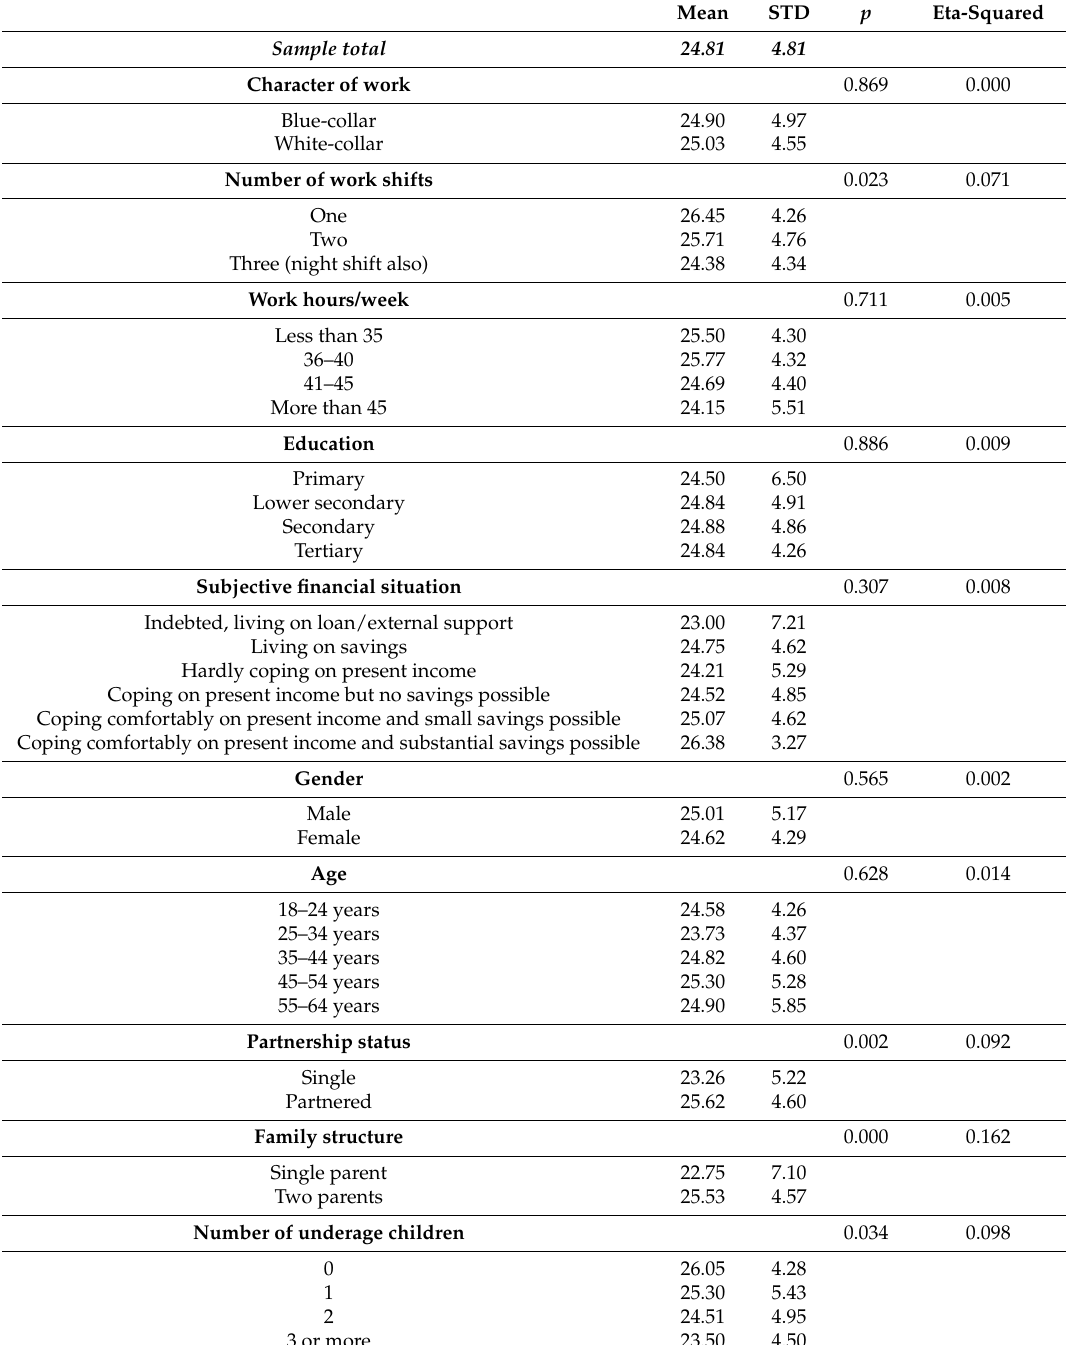
Table 1. Work-family balance mean scores by work-related, social and demographic categories. Analysis of variance (ANOVA) and eta-squared values, N =